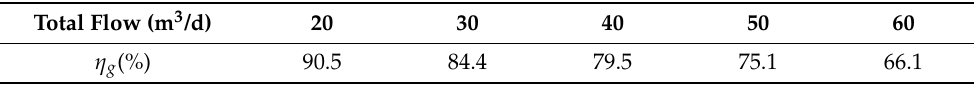
Table 2. Gas-water separation efficiency at gas holdup